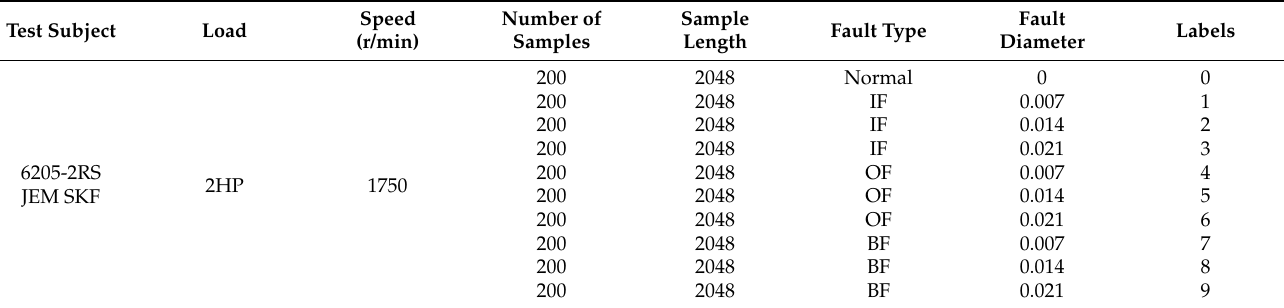
Table 6. Bearing data set of Western Reserve University.